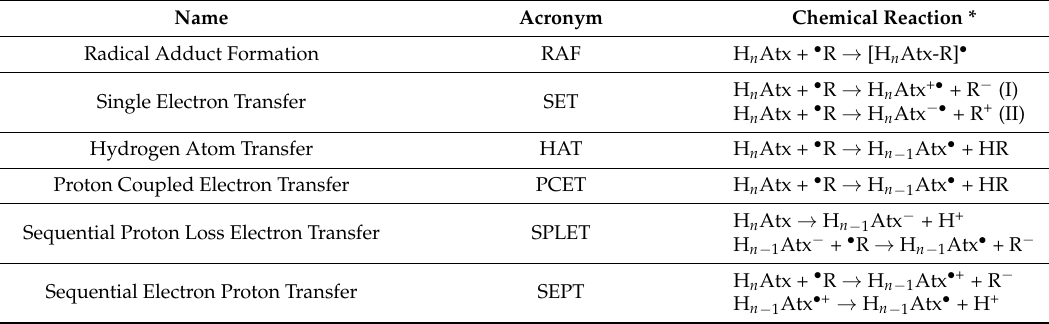
Table 2. Most common reaction mechanisms involved in the primary AOC of chemical